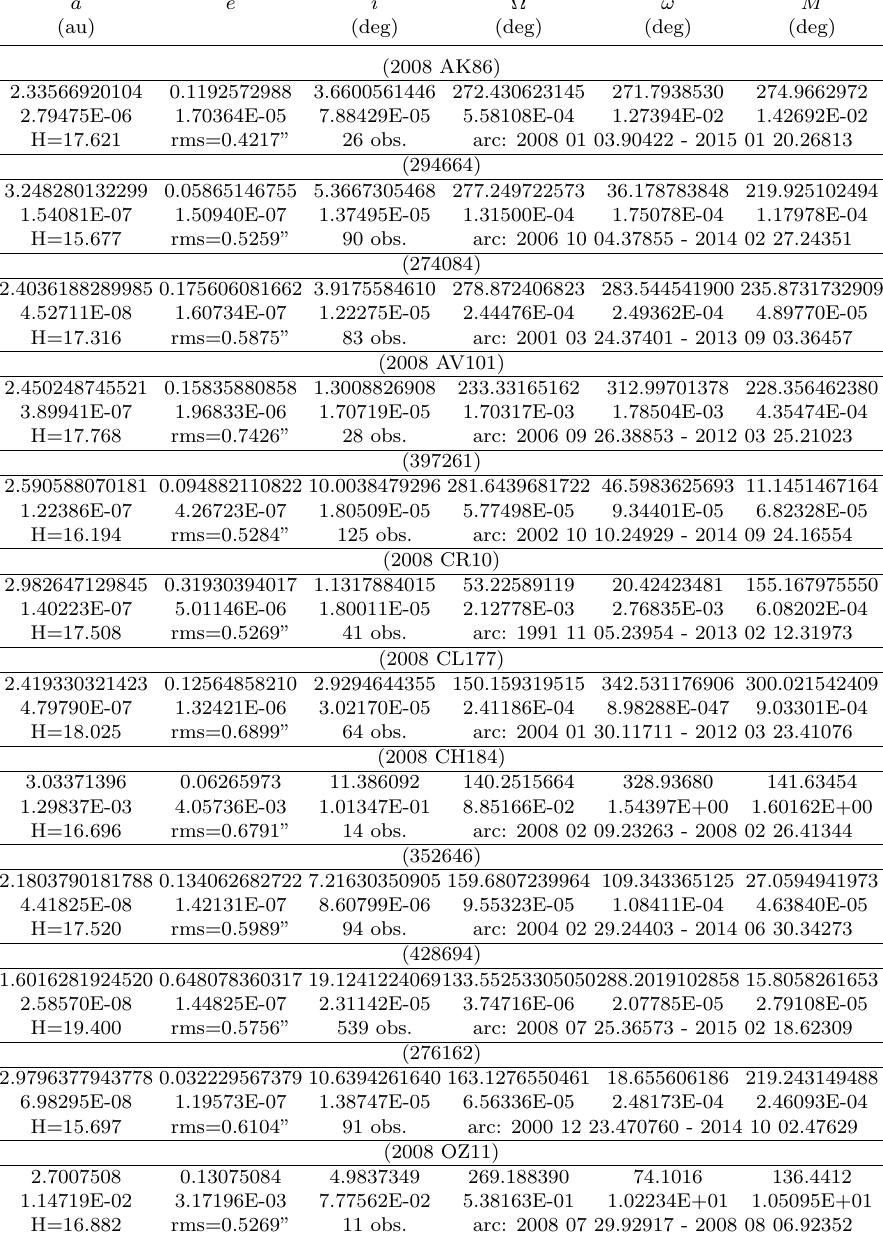
Table 3. High-precision orbital elements of the asteroids discovered at the Baldone Observatory in 2008–2013. The epoch JD2457000 = 2014 December 09.